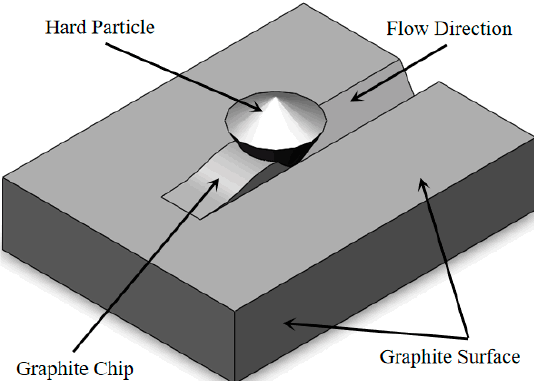
Figure 4. Wear mechanism.